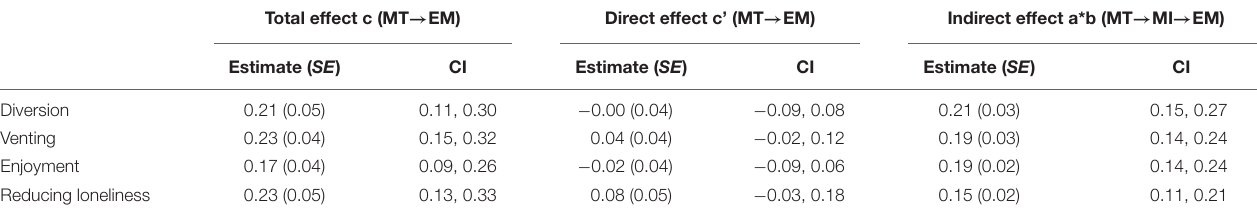
TABLE 7 | Mediation analysis of the effect of musical training on perceived efficacy of music in obtaining wellbeing goals, mediated by music’s importance.